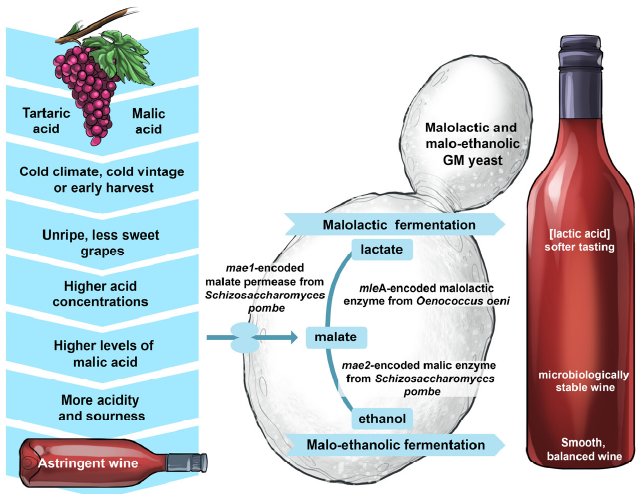
Figure 17. The construction of malolactic and maloethanolic wine strains of Saccharomyces cerevisiae which eliminates the need for malolactic bacteria to drive the conversion of malic acid into lactic acid. A genetically modified malolactic wine yeast strain, ML01, was commercialised and made available for commercial wine production in a few